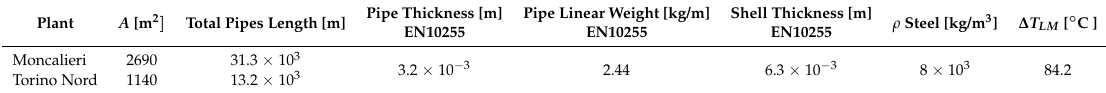
Table 3. Main parameters for plant heat exchanger sizing.